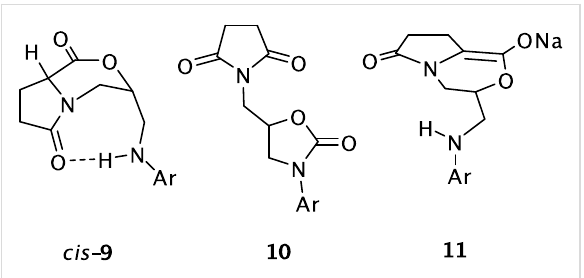
Scheme 3: Special product conformers, by-products and intermedi- ates of the transformation of 7 .